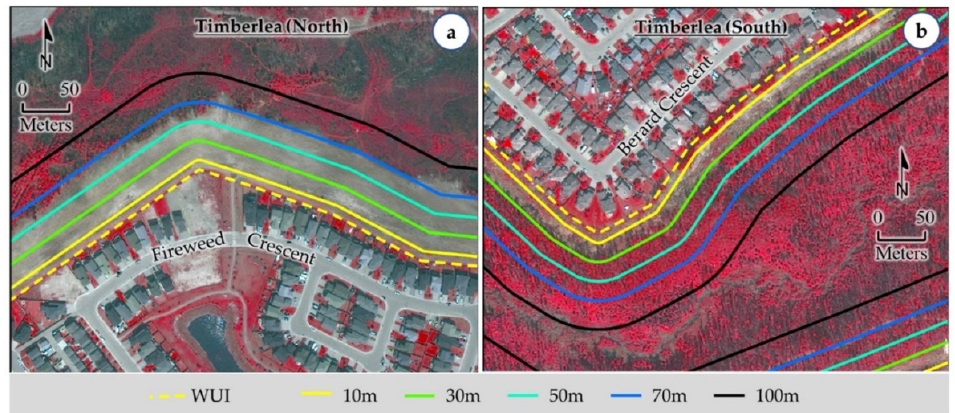
Figure 4. Relevant authorities removed vegetation between 30 and 70 m buffers from the WUI to protect the structures in the nearby Timberlea community ( a ), and existence of dense vegetation as shown in reddish color within 10 to 70 m from the WUI after the 2016 HRF event, and it was identified as vulnerable areas ( b ). (Source: ©Ahmed et al. 2018 licensed under CC BY.).